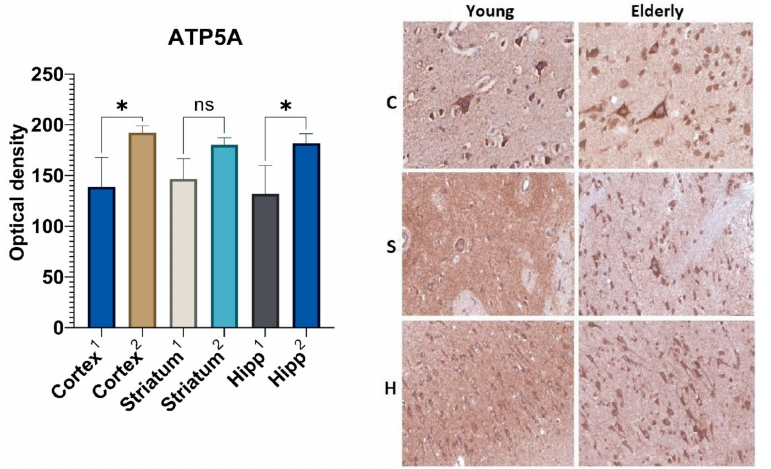
Figure 5. Results of ATP5A immunohistochemical staining: 1—young group, 2—elderly group; C—cortex, S—corpus striatum, H—hippocampus. *—differences are statistically significant ( p < 0.05). ns—differences are not statistically significant ( p > 0.05). Magnification 400 × for “C” and “S”, Magnification 200 × for